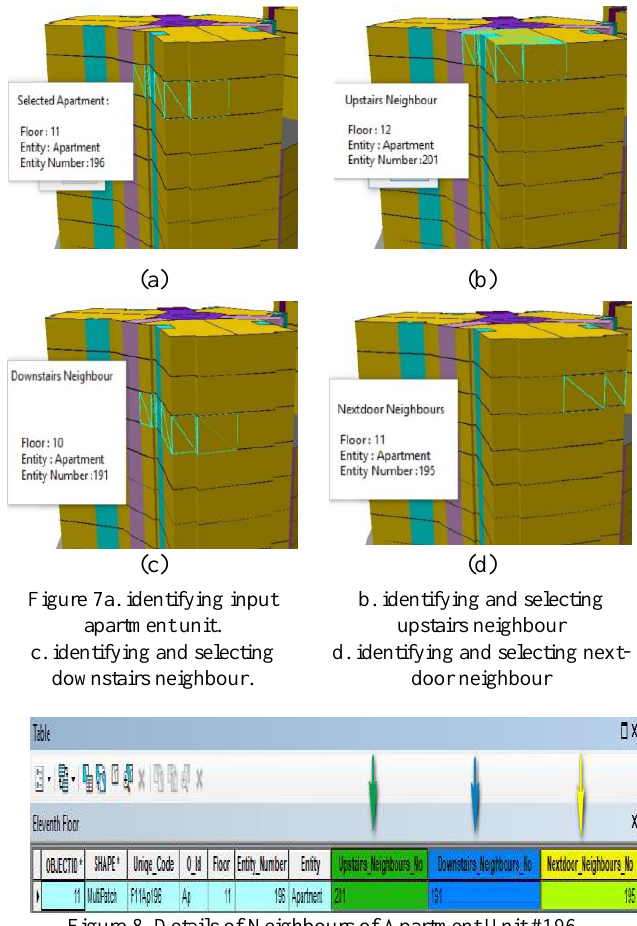
Figure 8. Details of Neighbours of Apartment Unit #196